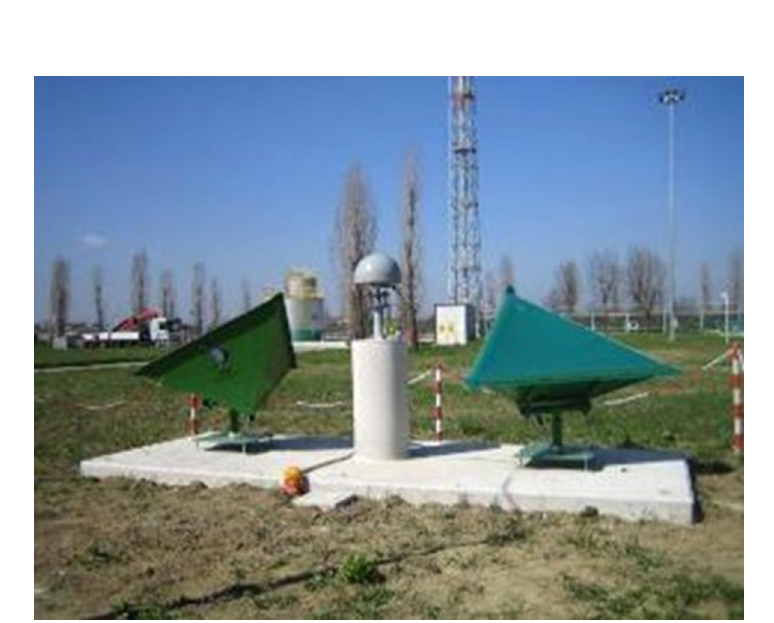
Fig. 21. – Continuous GPS onshore